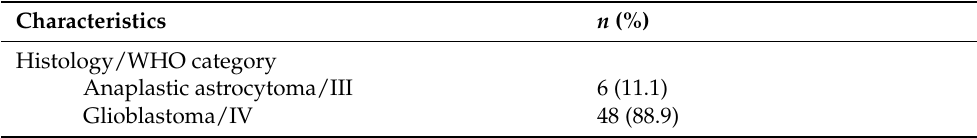
Table 1. Patients’ tumor characteristics ( n =